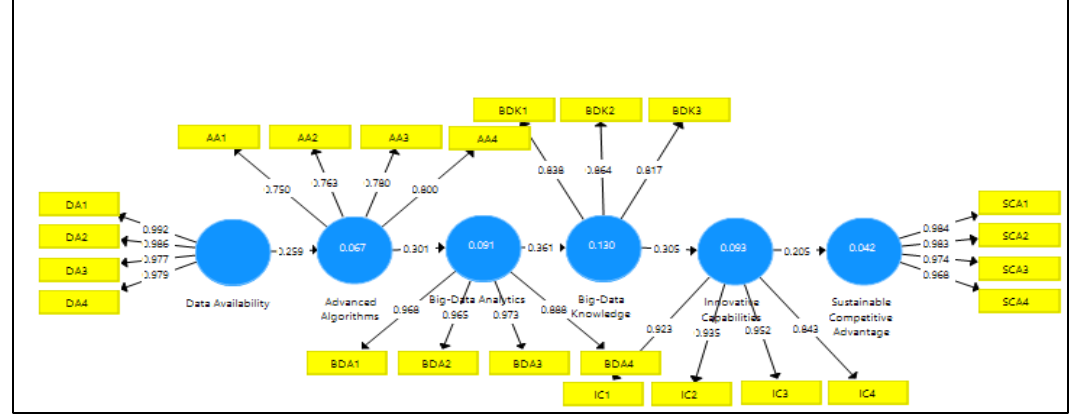
Figure.1. Conceptual